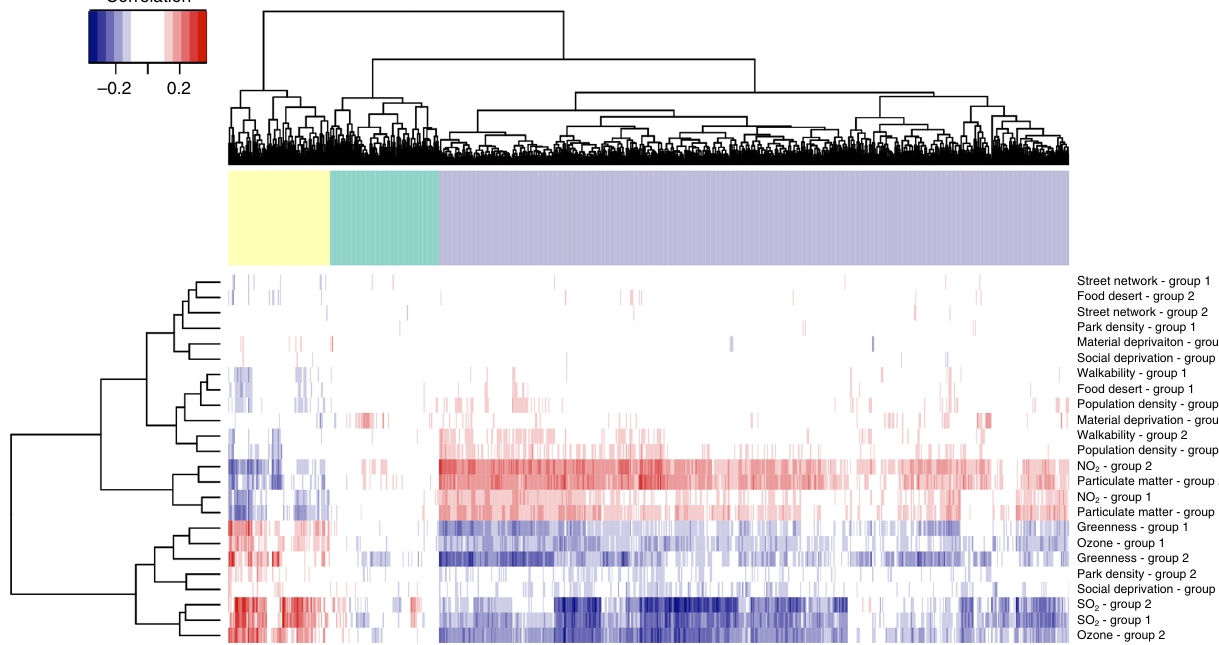
Fig. 3 Differentially expressed genes are associated with local ambient air pollution. Coinertia (CoIA) analysis between gene expression (columns) and fi ne-scale environmental variables (rows). CoIA analyses were performed on genes that were signi fi cantly differentially expressed among regions and the regulators of those genes (RDEG). CoIAs were computed between differentially expressed genes pro fi les and fi ne-scale environmental data (Supplementary Figs 11 and 12). We performed two sets (Group 1 and Group 2, each composed of a random draw of half the cohort) of CoIAs: each set included 10,000× resampling of 200 individuals (without replacement, from Group 1 or Group 2), and the CoIAs were performed between environment and gene expression for each of the 10,000 iterations. Supplementary Fig. 11 depicts the resampling scheme. The heatmap represents, for each Group 1 or Group 2, the median of each environment – gene associations from the cross-tabulated values distribution. Associations from Group 1 and Group 2 largely cluster together, indicating a strong signal of the association between fi ne-scale air pollution levels and gene expression. A permutation test ( n = 10,000 steps) indicates the that the correlations between the matrices are signi fi cant ( p = 0.00089 and p = 9.9 × 10 − 5 for Group 1 and 2